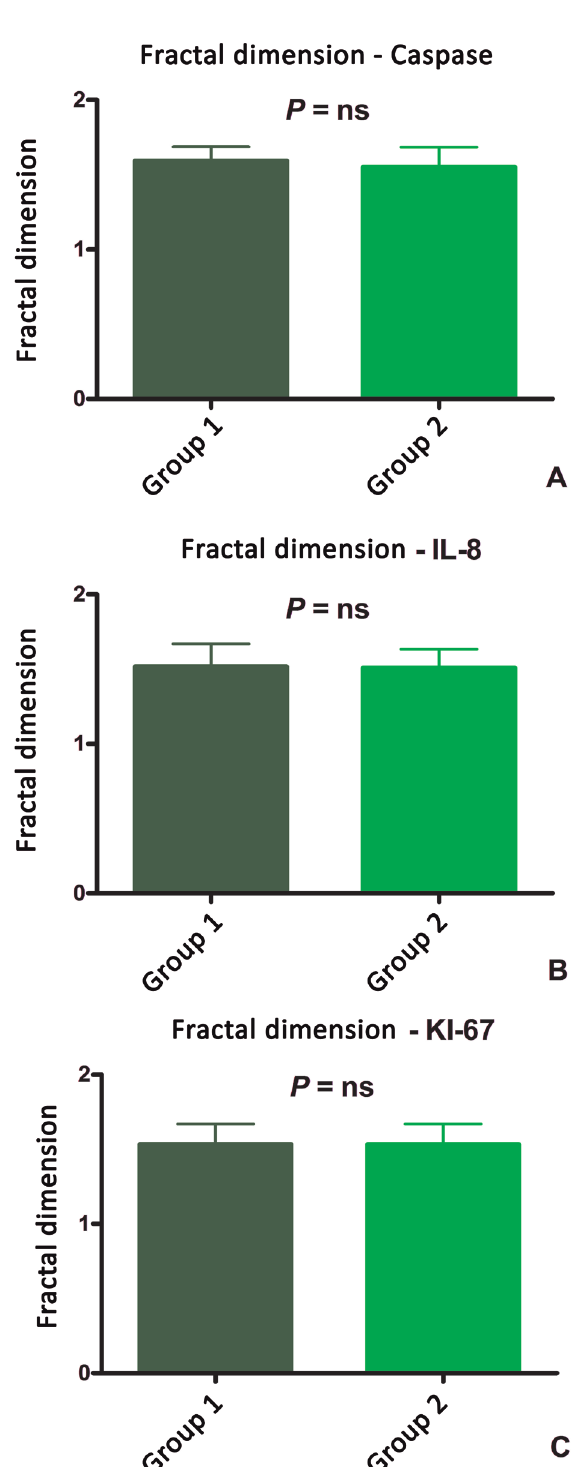
Fig. 2 - Histograms showing distribution of entropy in: (A) caspase. (B) IL-8 and (C) KI-67. Group 1: solution with histidine-tryptophan- ketoglutarate. Group 2: solution with histidine-tryptophan-